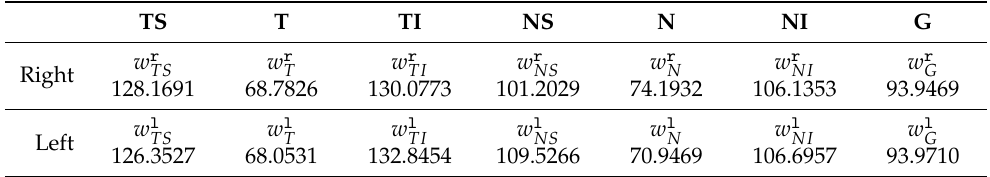
Table 3. Mean values in µm of the RNFL thickness calculated for all sectors in both eyes. Values used in asymmetry metrics ¯ ∆ S , i and | ¯ ∆ S , i |